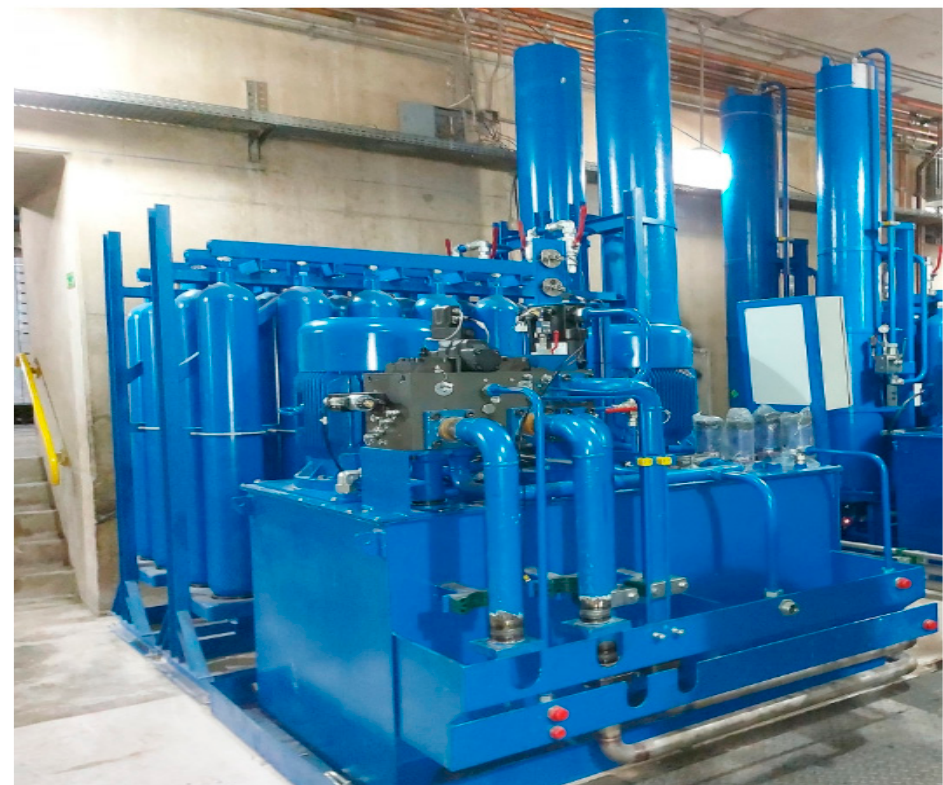
Figure 5. Hydraulic power unit of the speed governor.